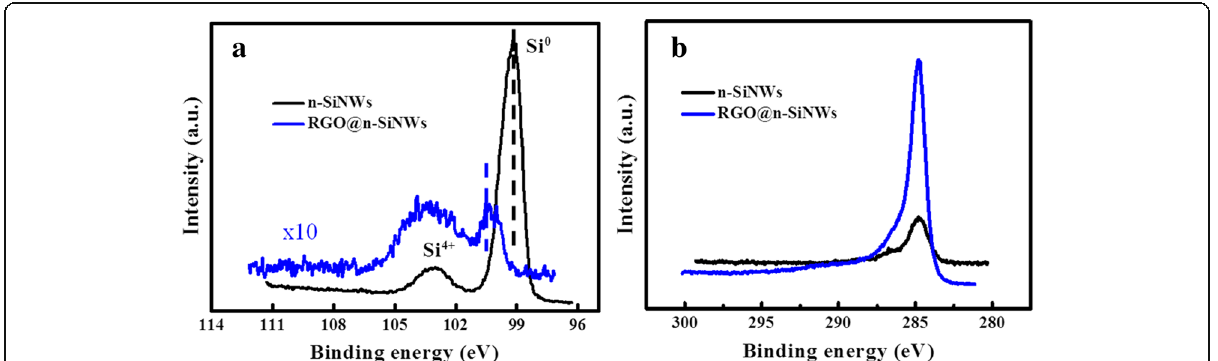
Fig. 7 a XPS spectra of Si2p peaks for n-SiNWs and RGO@n-SiNWs. b XPS spectra of C1s peaks for n-SiNWs and RGO@n-SiNWs